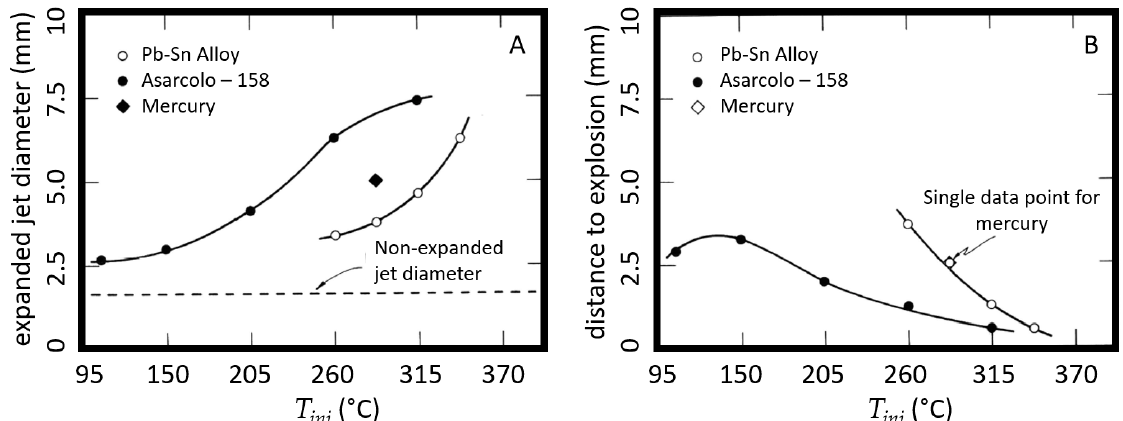
Figure 3. Experimental data of the influence of the injection temperature ( T inj ) for different materials on (adapted from Reference [50]): ( A ) Jet expansion; ( B ) distance to explosion.